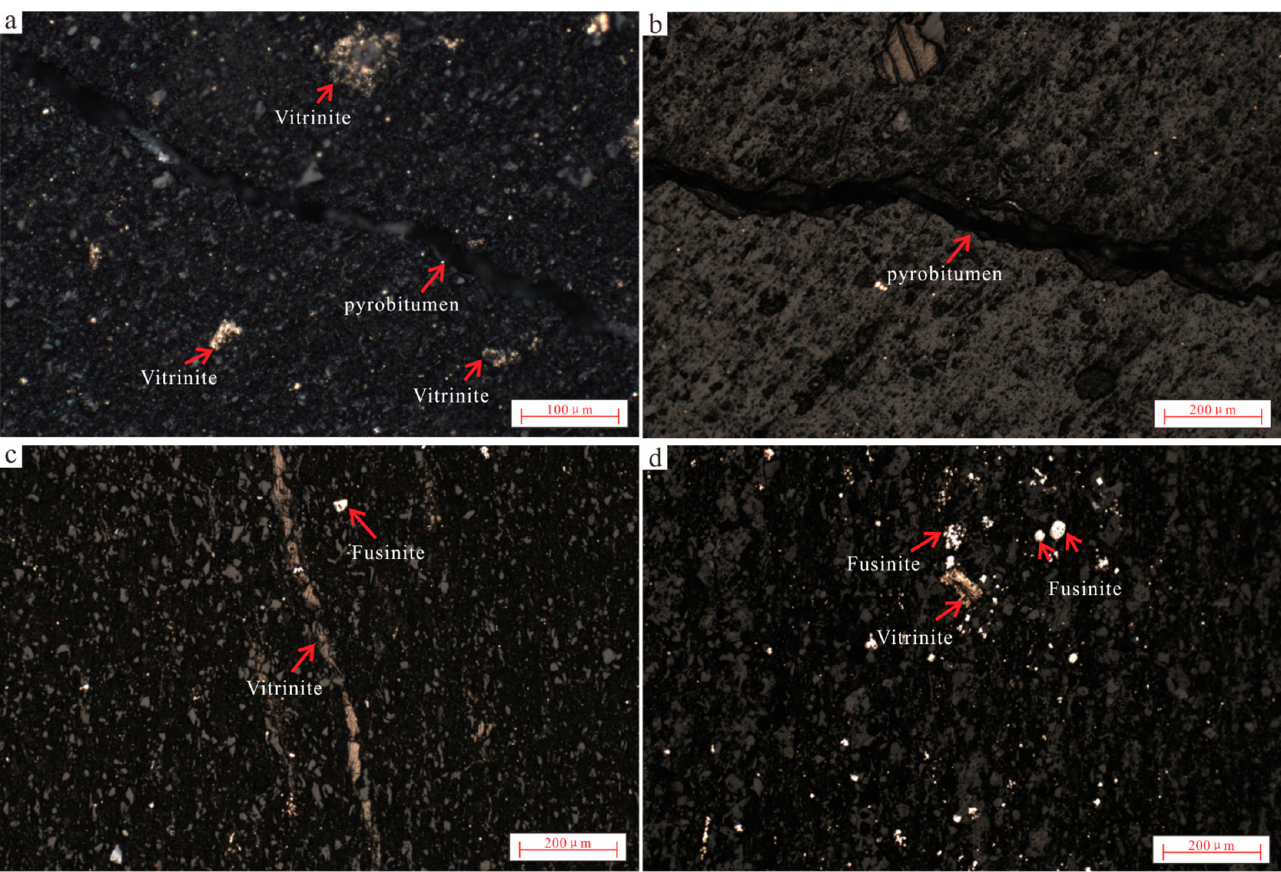
Figure 7. Photomicrographs of organic matter in reflected white light of the Wufeng–Longmaxi shale on the Yangtze Platform, South China. ( a ) Pyrobitumen in the image is black, and vitrinite is gray and irregularly shaped, sample number: YH-242; ( b ) pyrobitumen in the image is black, sample number: SH9-15-1; ( c ) vitrinite in the image is pale gray and has an elongated shaped, sample number: YH-242; ( d ) vitrinite in the image is pale gray and has an irregular or elongated shape, and fusinite is white and has an irregular or globular shape, sample number: SH9-15-1.